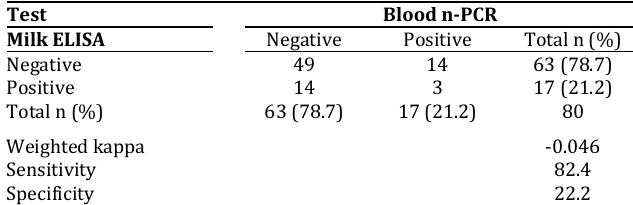
Table 4. Comparison between infection rates of Toxoplasma gondii in local lactating goats using ELISA in milk and n-PCR in